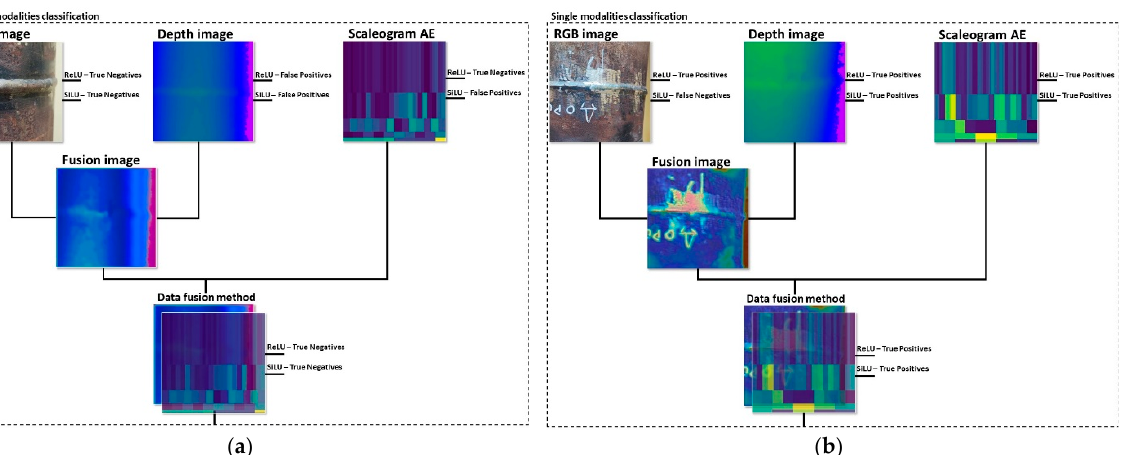
Figure 13. A result of classification for different approaches: ( a ) a test sample without a defect; ( b ) a test sample with a defect.